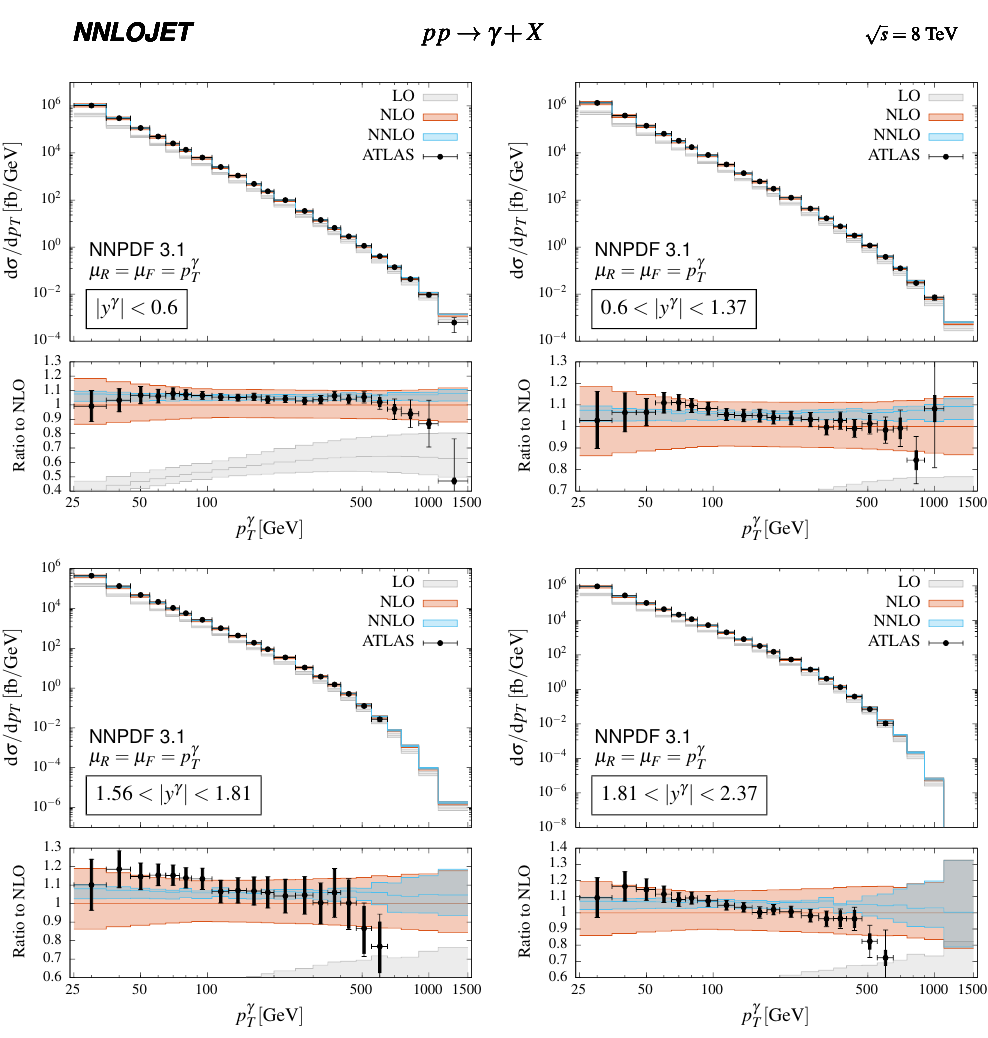
Figure 5 . Transverse energy/momentum distribution of isolated photons at LO, NLO, NNLO in four di(cid:11)erent rapidity bins, from central (top left) to most forward (bottom right). The results are compared to 8 TeV ATLAS data